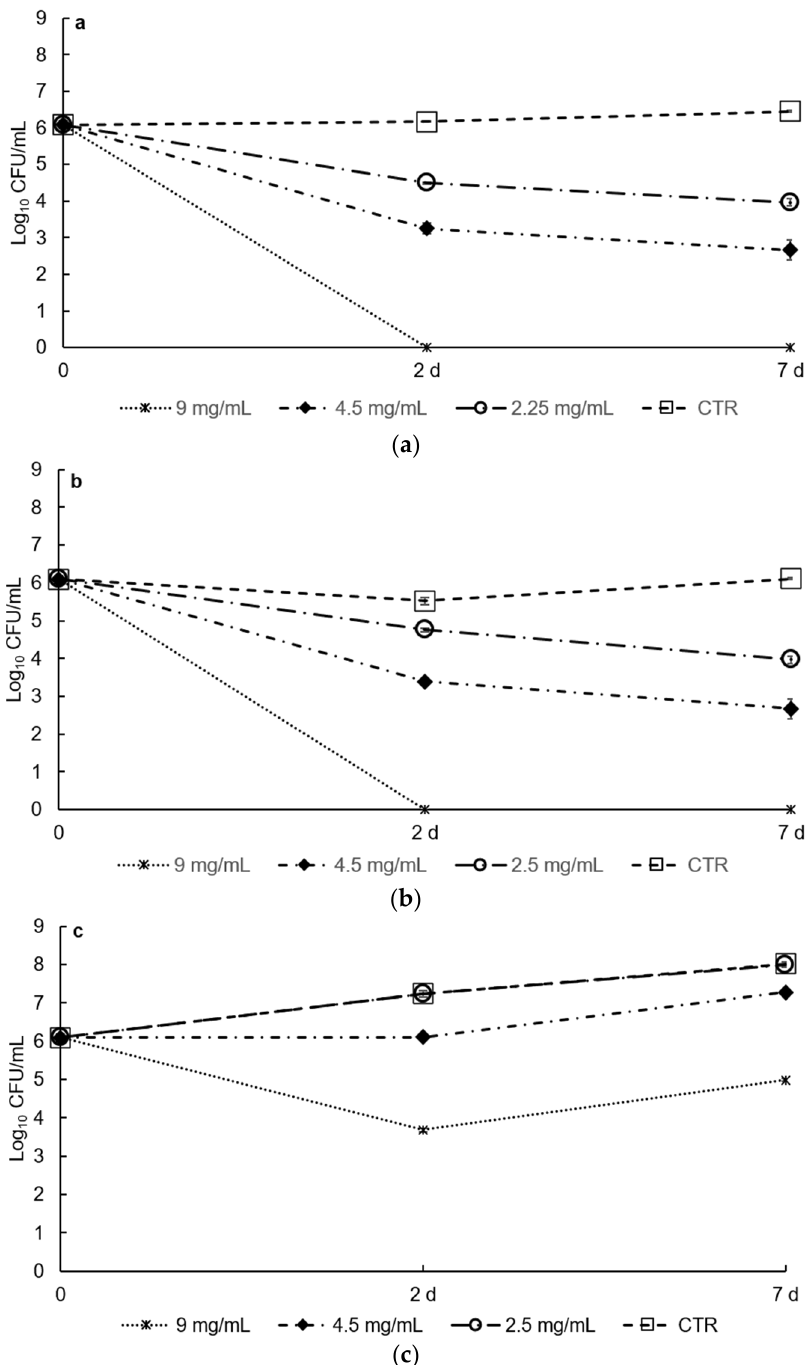
Figure 5. Effects of different concentrations of DES (9, 4.5, and 2.5 mg/mL) on the growth of ( a ) S. aureus DSM 20231 , ( b ) E. coli DSM 30083, and ( c ) L. moncytogenes DSM 20600; low-fat UHT milk was used as food matrix, and antibacterial activity of the extracts was tested at 6 °C for 7 days by comparing bacterial growth with control conditions (CTR, low-fat UHT milk alone). Values are the average of four biological replicates (see materials and